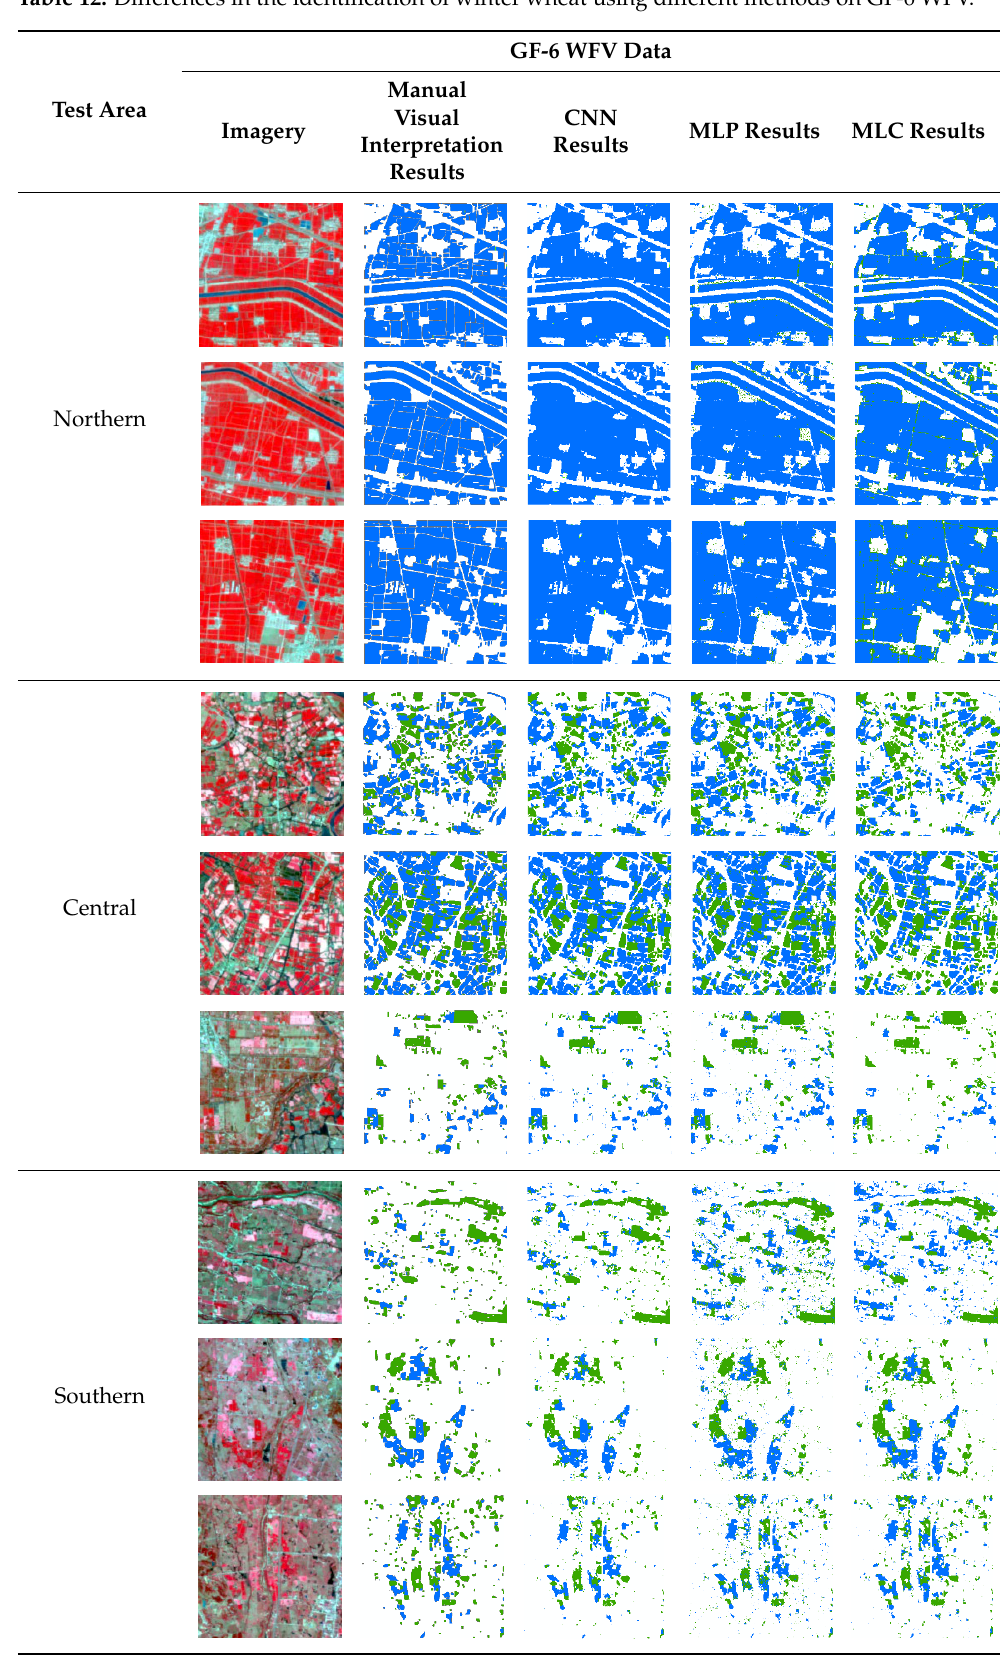
Table 13. Results of the correlation method to identify winter wheat on GF-6 WFV. Test Area